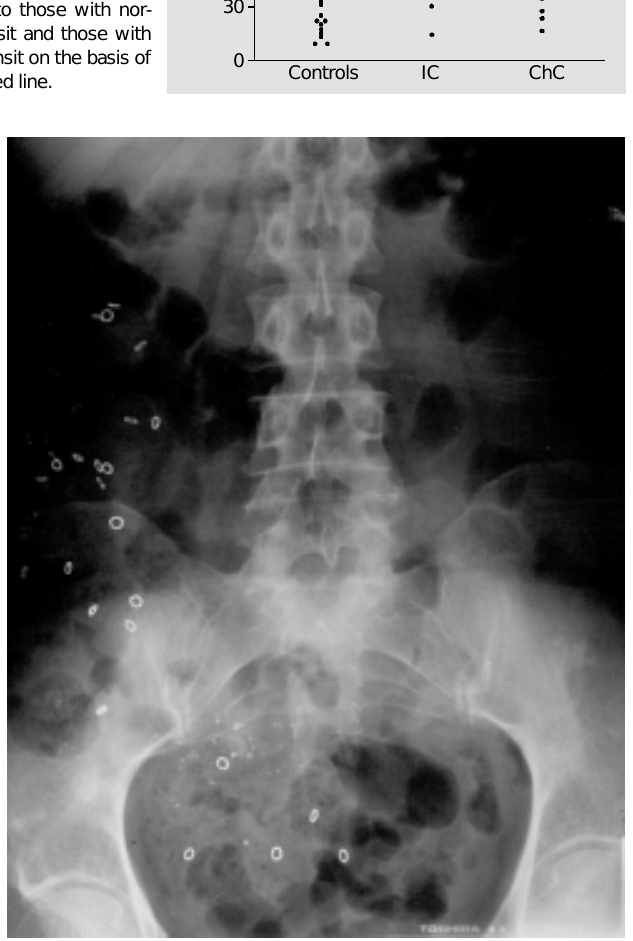
Figure 2 - Colonic inertia in a constipated patient with Chagas’ disease (ChC). An X-ray obtained on day 7 shows stasis of the radiopaque markers in the ascending colon.